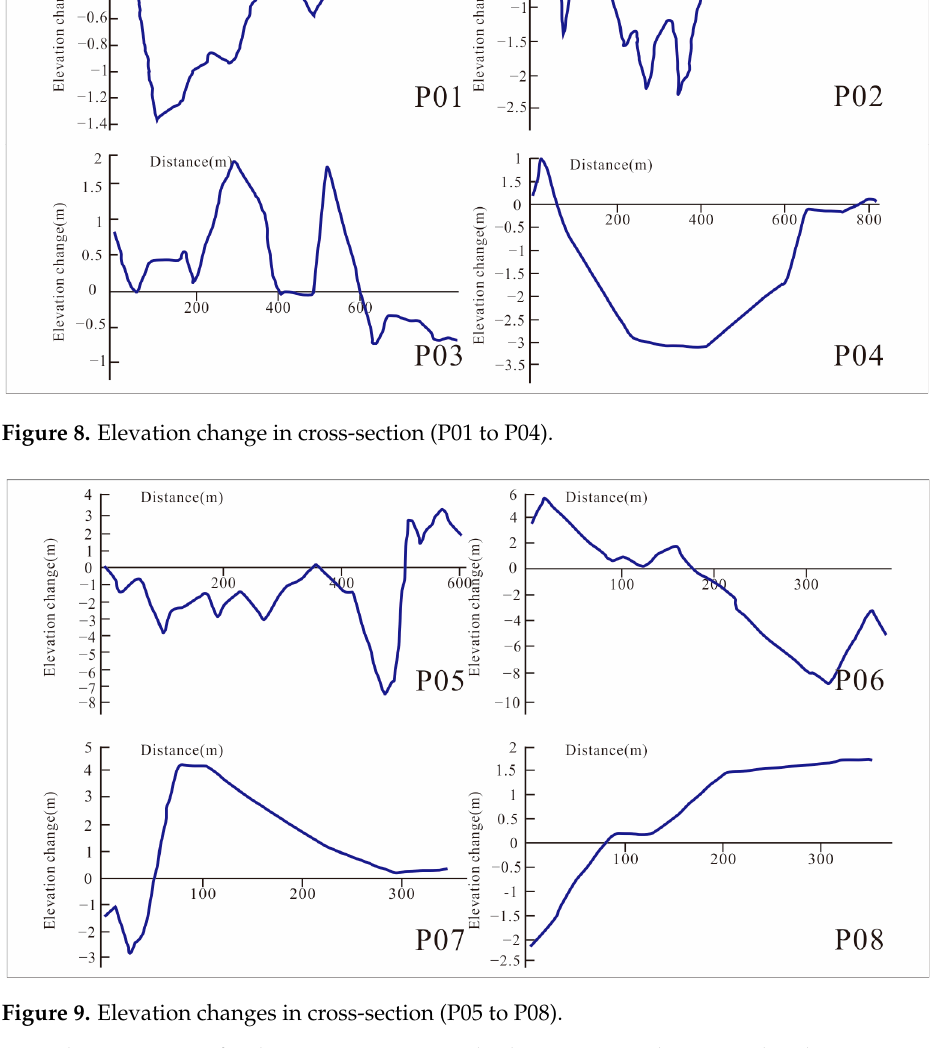
Figure 9. Elevation changes in cross-section (P05 to P08).